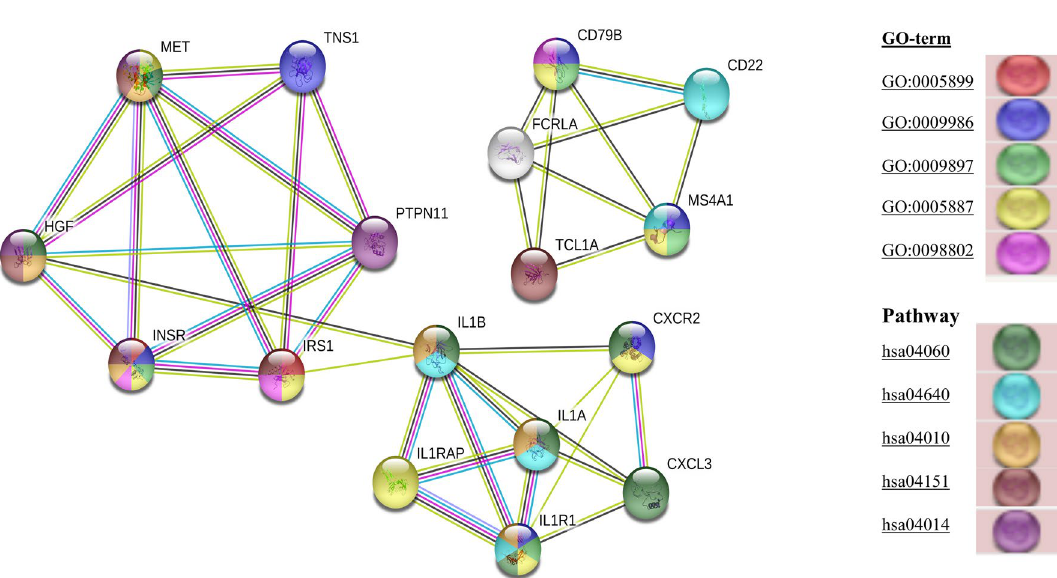
Figure 6. Pathway analysis and cellular processes analysis of Hub genes on string database version 11.0 (https:// string- db. org/). Each node is representative of a gene interacting within the clusters. The nodes present in the clusters are filled by different colors respective of the pathway shared by that gene having significant FDR in the KEGG database. The color codes are provided in the right corner and details of respective pathways are provided in Table